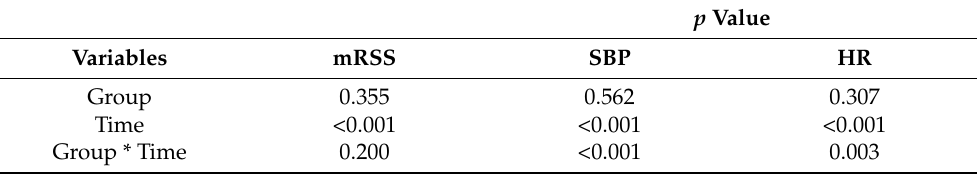
Table A3. The results of mixed-effect models for the repeatedly measured outcomes. mRSS: modified Ramsay Sedation Scale, SBP: systolic blood pressure, HR: heart rate. * Asterisk indicates interaction between the two factors (group and